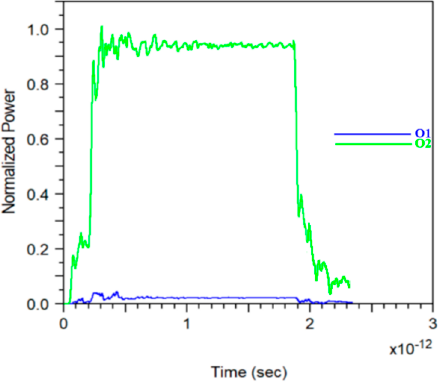
Figure 7. The pulse response for proposed optical switch.